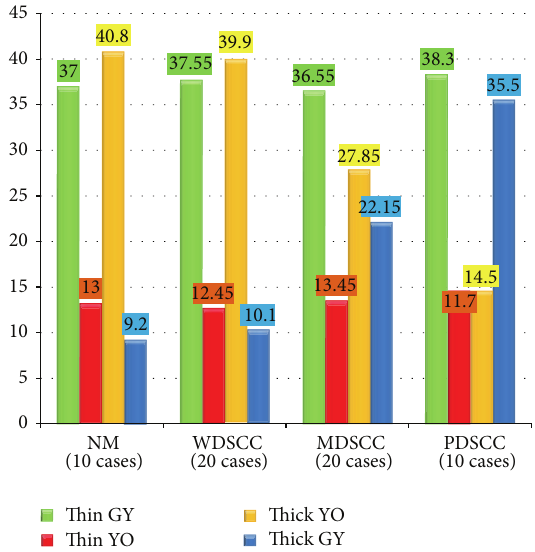
Figure 5: Polarization colours of thin and thick fibres in NM, WDSCC, MDSCC, and PDSCC cases. ANOVA analysis: for thin fibres: 𝐹 value: 1.607; 𝑃 value: 0.1979; interpretation: not significant. For thick fibres: 𝐹 value: 224.90; 𝑃 value: 0.0000; interpretation: highly